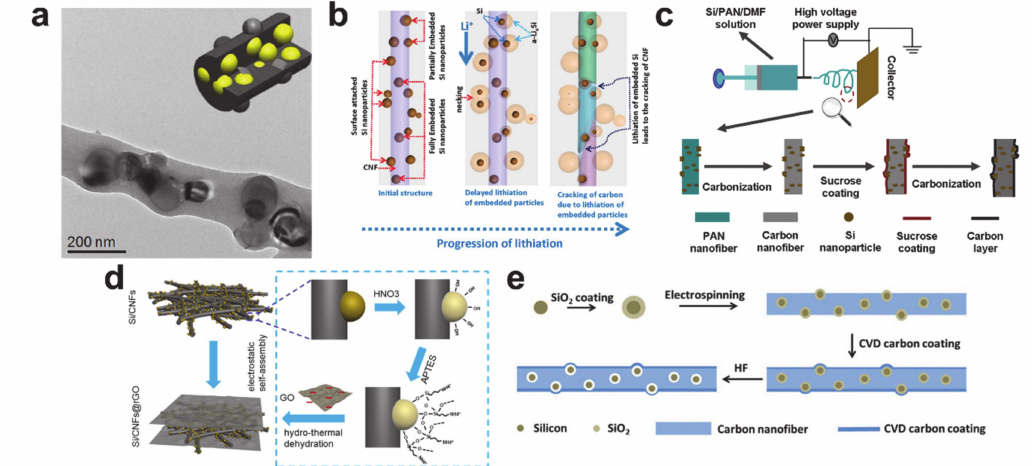
Figure 19. Silicon nanoparticles embedded carbon nanofiber anode materials. ( a ) Schematic diagram and morphology of carbon nanofiber containing silicon nanoparticles (reprinted with